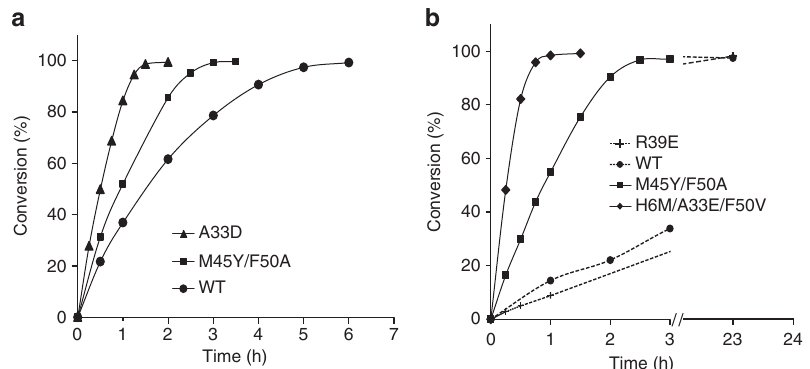
Figure 4 | Enzyme-catalysed transformations. ( a ) Progress curves of the Michael-type addition of acetaldehyde 3 (50mM) to trans -nitrostyrene 5a (2mM, 18mg) catalysed (0.7mol%) by wild-type 4-OT or 4-OT mutants A33D or M45Y/F50A. The reactions were carried out in buffer (20mM NaH 2 PO 4 /10% ethanol (v/v)) at pH 7.3. ( b ) Progress curves of the Michael-type addition of butanal 4 (50mM) to trans -nitrostyrene 5a (2mM, 18mg) catalysed (0.7mol%) by wild-type 4-OT or 4-OT mutants R39E, H6M/A33E/F50V or M45Y/F50A. The reactions were carried out in buffer (20mM NaH 2 PO 4 /10% ethanol (v/v)) at pH 5.5. These progress curves are derived from the preparative scale reactions listed in Table 1.